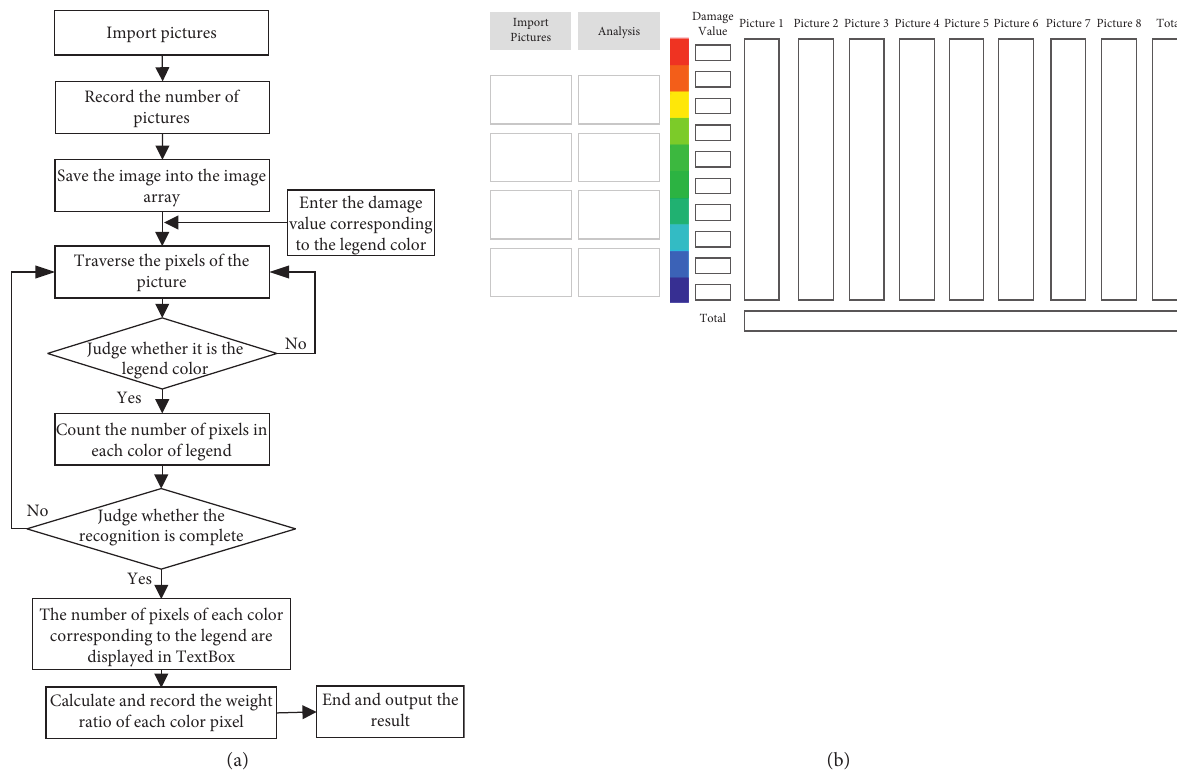
Figure 1: Flowchart of image recognition program and the interface of rock damage image recognition